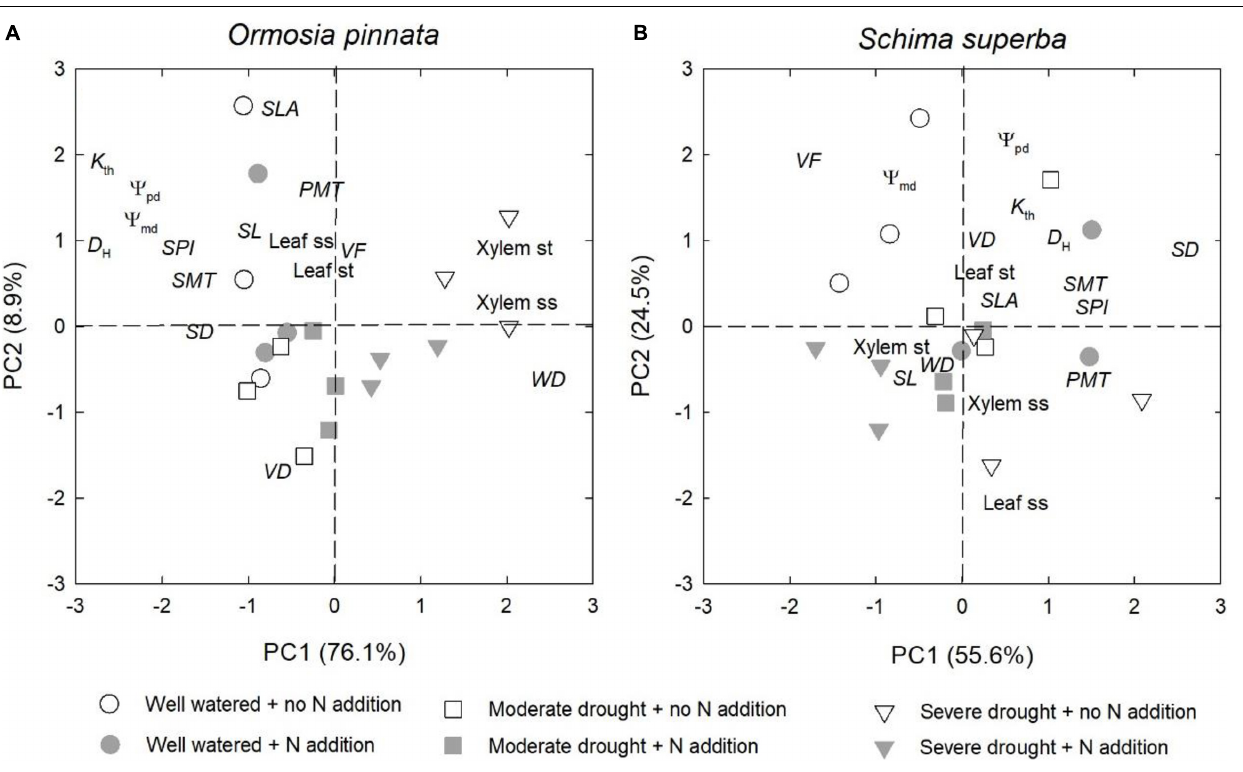
FIGURE 8 | Effects of N addition and drought on the physiological and anatomical traits of O. pinnata (A) and S. superba (B) using principal component analysis (PCA). See Table 1 for trait codes.